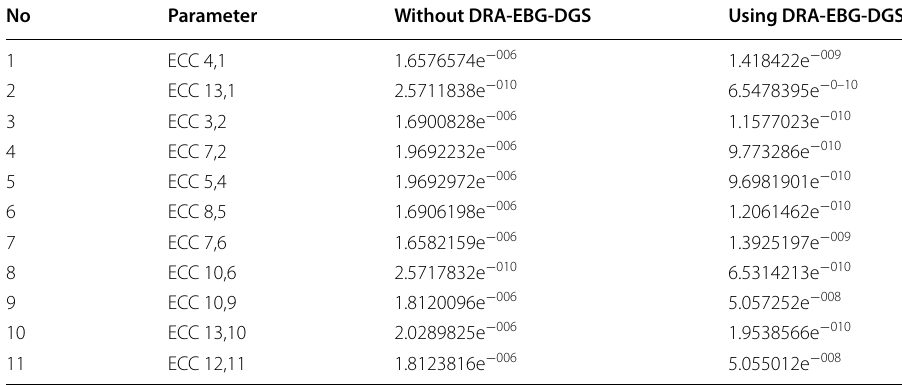
Table 5 Comparison of ECC